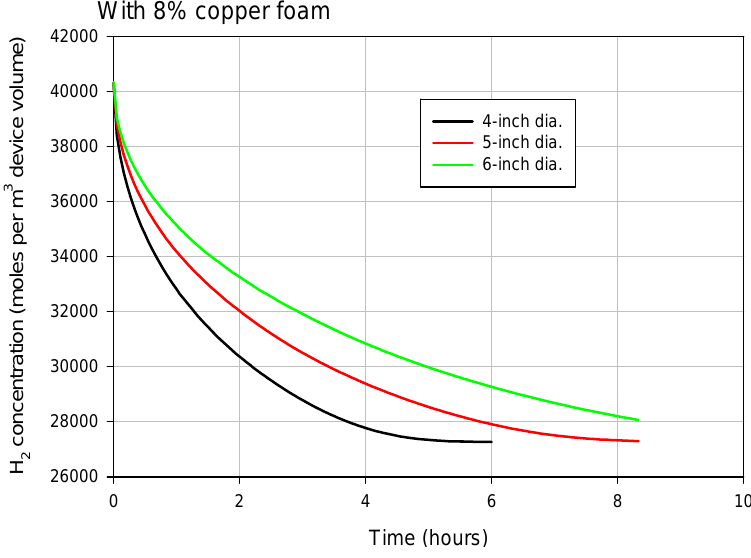
Figure 15. Modeled hydrogen release from cylinders with various inside diameters containing copper